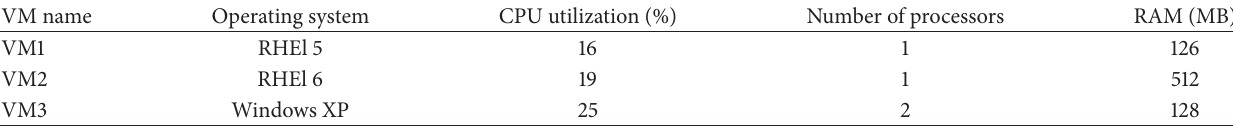
Table 4: Local list of node 1 (S1).